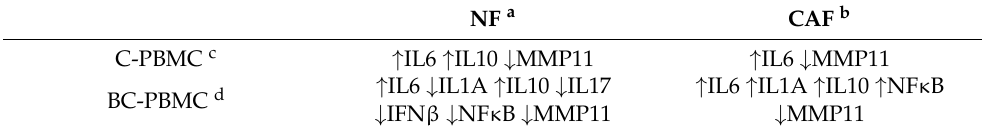
Table 2. Summary of the inflammatory selected set gene expression in fibroblast after